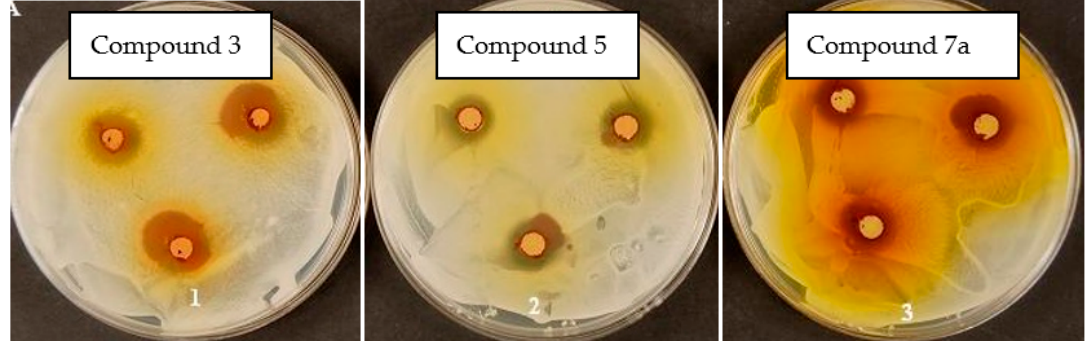
Figure 9. Candida albican treated with dyes 3, 5, and 7a.